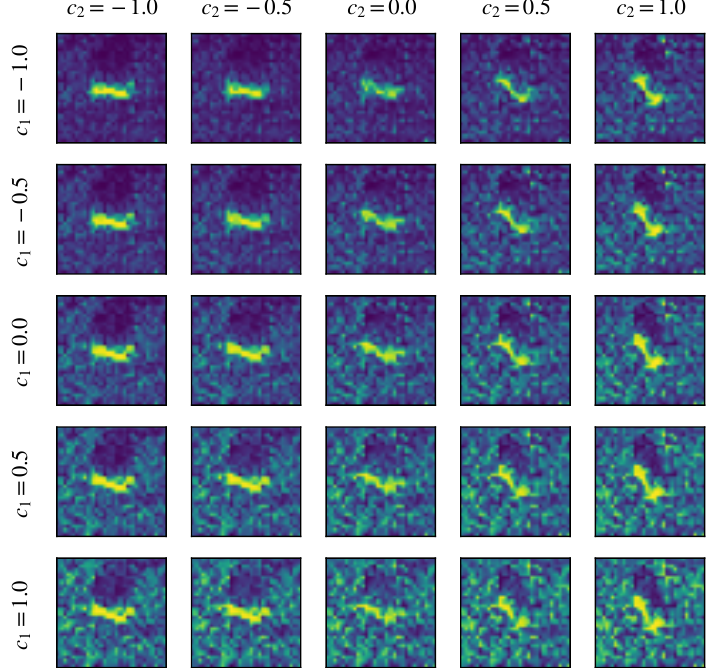
Figure 14. The synthesized SAR images (with background). Two latent codes are used.